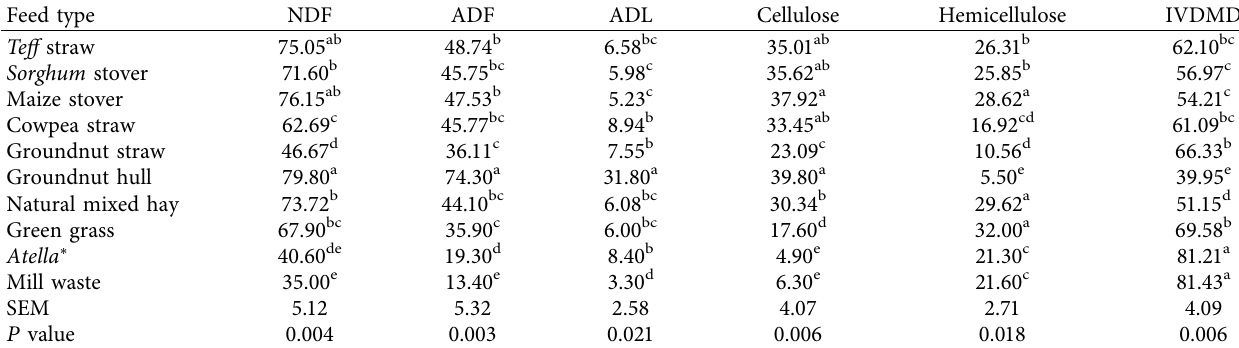
Table 3: Fiber fractions and digestibility of major feed resources (% of DM).